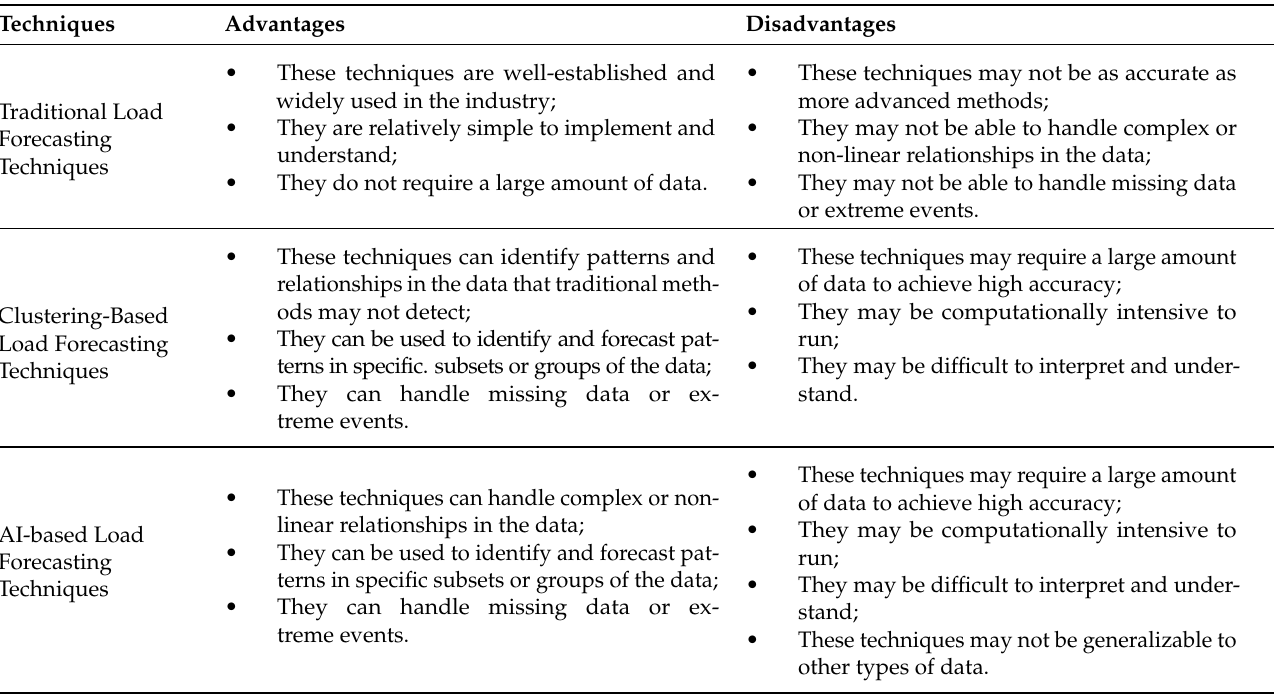
Table 7. Summary of advantages and disadvantages for all LF